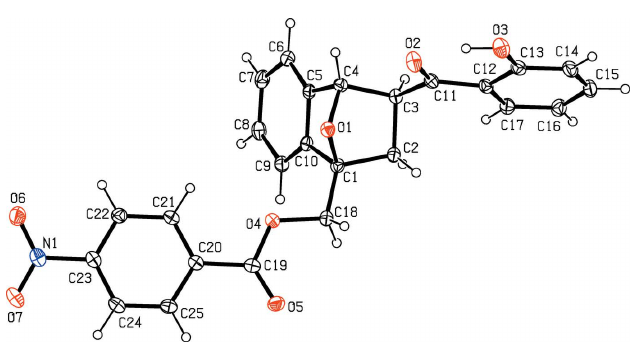
Figure 2 The molecular structure of the title compound with displacement ellipsoids drawn the 30% probability level.